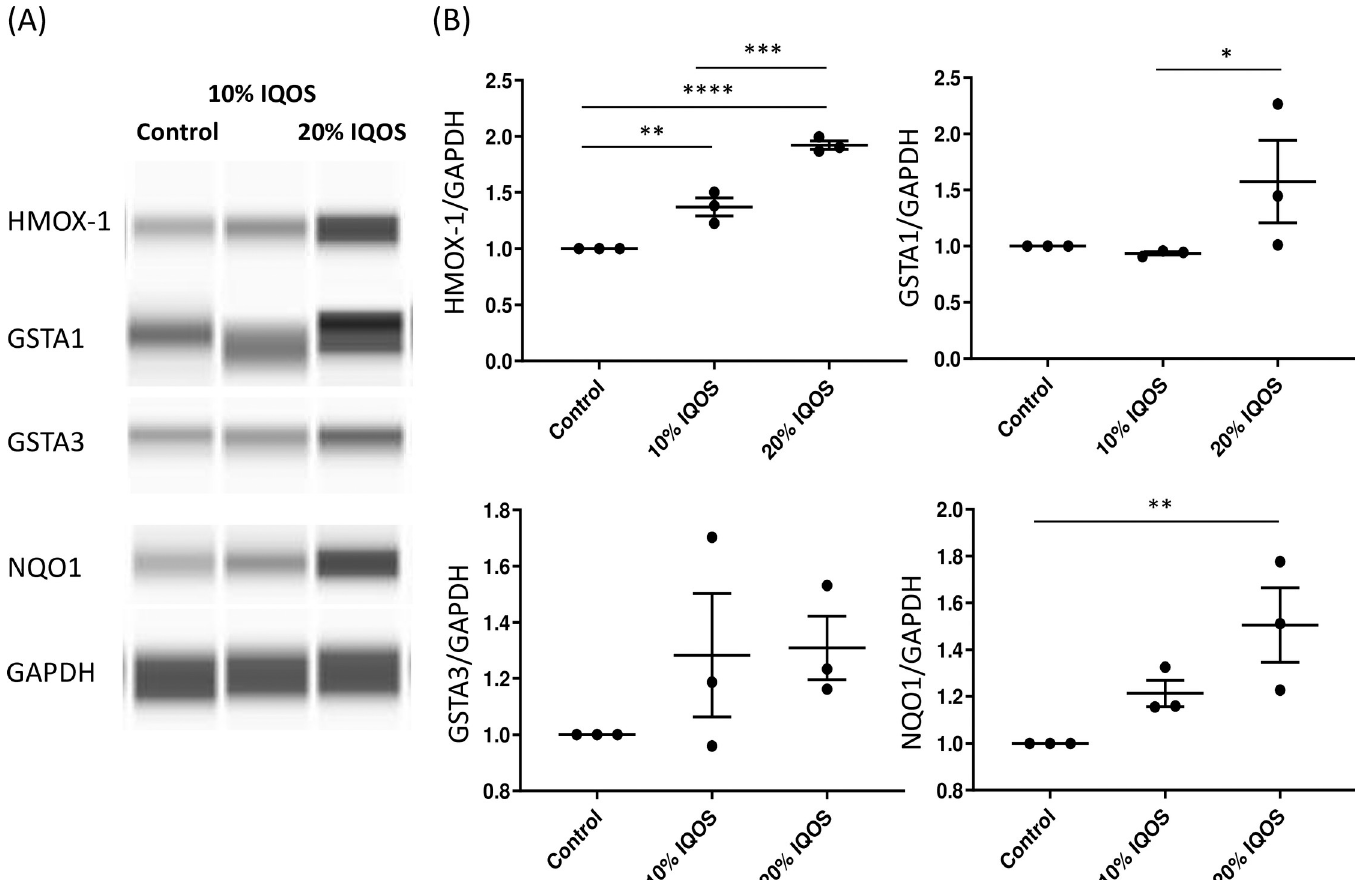
Fig 3. HMOX-1 and NQO1 but not GSTA1 and GSTA3 proteins in rat ATI-like cells are induced at 48 h after 10% and/or 20% IQOS CSE stimulation. A) representative blot, B) quantitation of HMOX-1, GSTA1, GSTA3 and NQO1 relative protein expression. Data represent results from three independent experiments. � : p < 0.05, �� : p < 0.01, ��� : p <